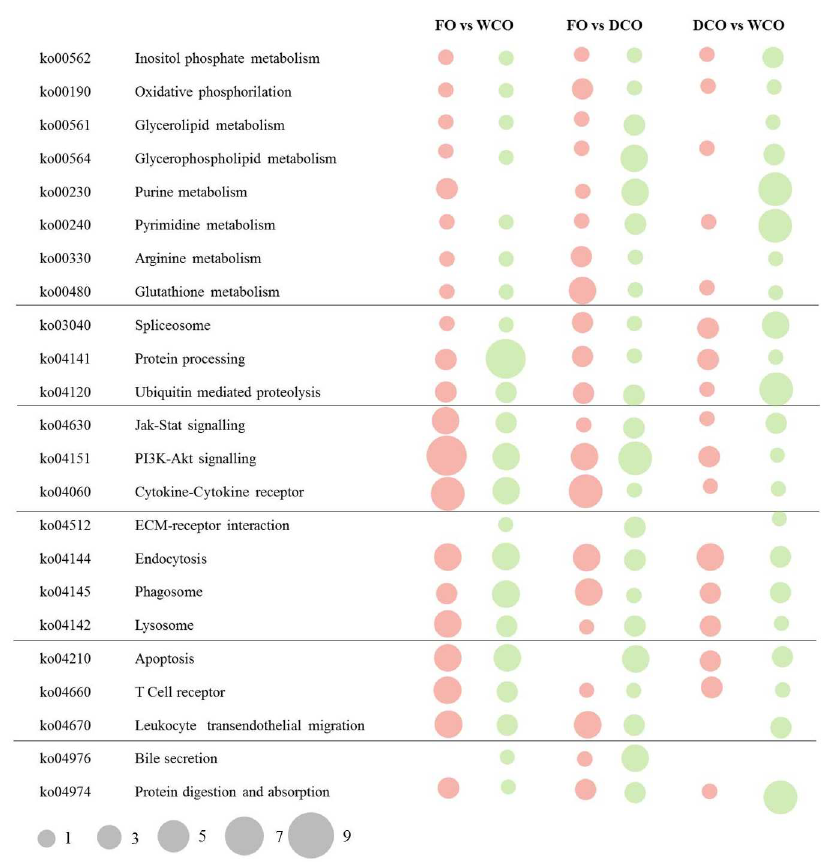
Fig 2. Ranking of differentially expressedpathways in midgut of Atlantic salmon between fish fed a feed based either on Fish Oil (FO), Wild type Camelina Oil (WCO) or EPA+DHA Camelina Oil (DCO). Pathway analysis was performed using the Kyoto Encyclopedia of Genes and Genome (KEGG). The area of the circle is scaled to the numberof DEG within each pathway. Up-regulatedgenes, red; down- regulatedgenes,